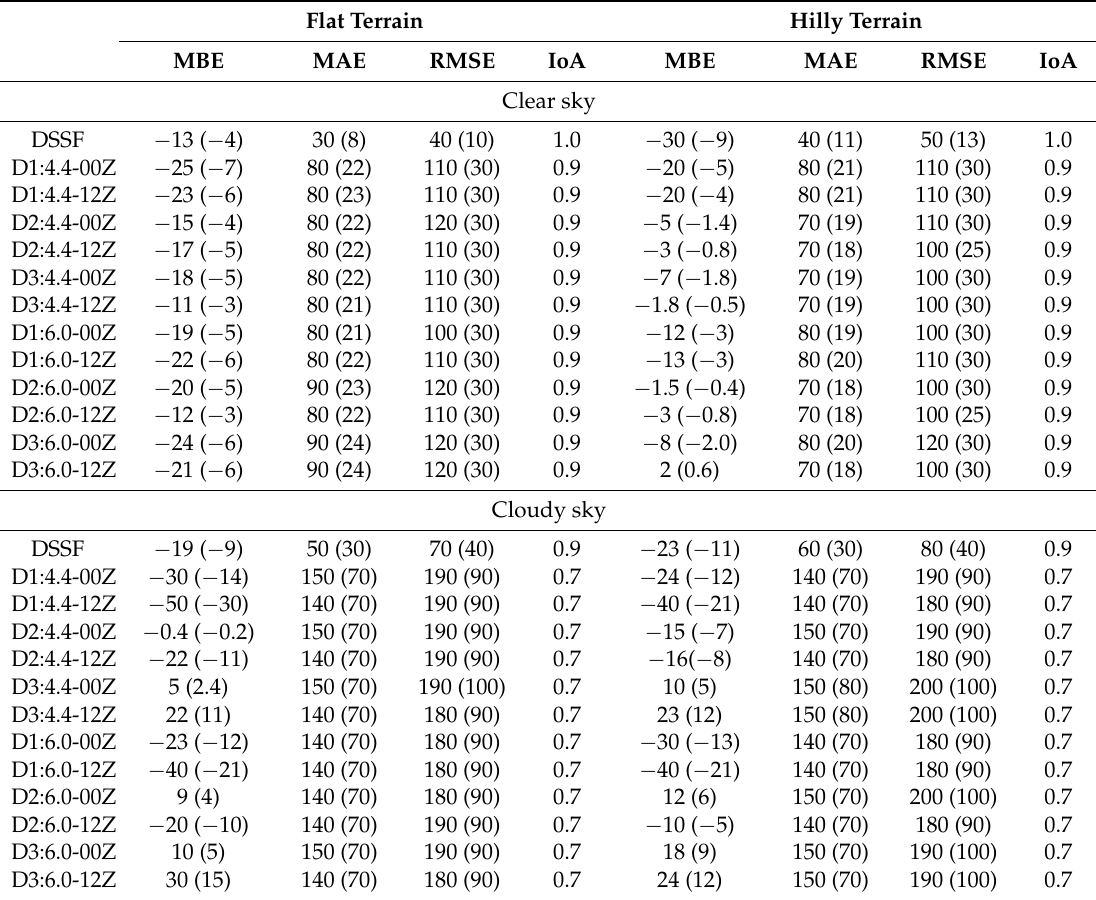
Table 6. Hourly solar radiation error and accuracy statistics, depending on flat or hilly terrain and clear or cloudy conditions, during the winter 2010–2011. MBE, MAE and RMSE in W ¨ m ´ 2 . Relative errors (%) rMBE, rMAE and rRMSE in brackets at the right. Flat Terrain Hilly